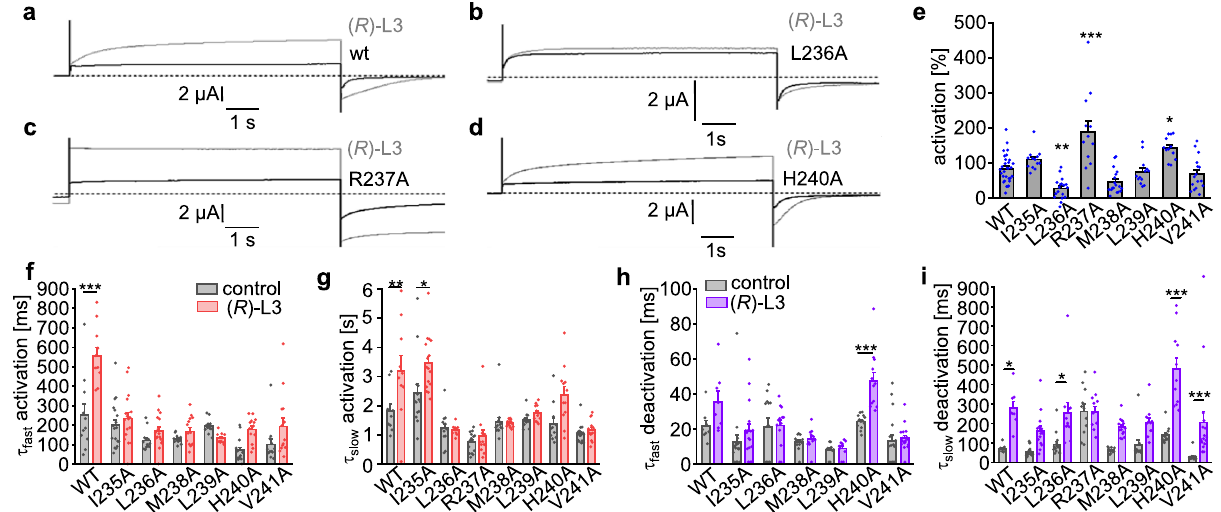
Fig. 4 Sensitivity of S4 residues to ( R )-L3 modulation. a – d Representative current traces of wildtype ( a ) and mutant channels L236A ( b ), R237A ( c ) and H240 ( d ). e Current amplitude activation of K v 7.1 channel mutants by 1 µ M ( R )-L3 expressed as percent change in current measured at the end of a 7-s pulse to + 40 mV ( n = 30 for WT, n = 13 for I235A, n = 18 for L236A, n = 12 for R237A, n = 18 for M238A, n = 13 for L239A, n = 12 for H240A, n = 16 for V241A). Signi fi cance of mean differences was evaluated by one-way ANOVA and posthoc mean comparison Tukey Test (* p < 0.05, ** p < 0.01, *** p < 0.001). f – i Effect of ( R )-L3 on hK v 7.1 channel mutant activation and deactivation rates. Kinetics were evaluated in both absence and presence of 1 µ M ( R )-L3 and fi tted by two-component exponential function (number of independent oocytes for ( f – i ) are given in SI Table